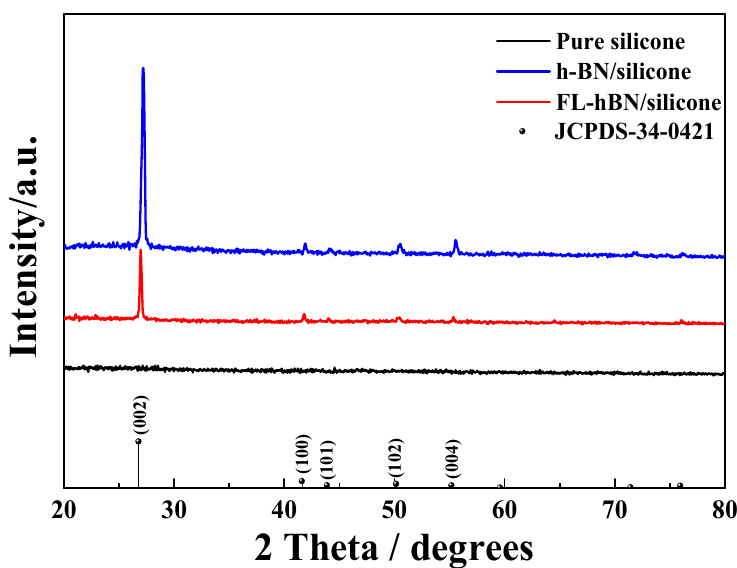
Figure 6. XRD patterns of pure silicone, (30%) h-BN/silicone and (30%) FL-hBN/silicone. Polymers 2020 , 01 , x FOR PEER REVIEW Figure 7a,b show the thermal diffusivity and thermal conductivity of the composites of h- BN/silicone and FL-hBN/silicone composites with different loading ratios. Table 1 summarizes the physical properties of all of these composites. The results showed that both thermal diffusivity and thermal conductivity increased with the increasing content of the fillers. The composites containing FL-hBN exhibited much higher thermal conductivity than those with pristine h-BN at the same fraction in silicone. The thermal conductivity of 30% FL-hBN/silicone (30 wt.% FL-hBN into silicone) composites was 0.515 W/m·K, which was higher than that of 30% hBN/silicone composites (0.424 W/m·K). Compared to pristine silicone, the thermal conductivity of the FL-hBN/silicone composite enhanced by 230% (2.3 times) by introducing 30 wt.% FL-h-BN. Table 1. The physical properties of all the composites.